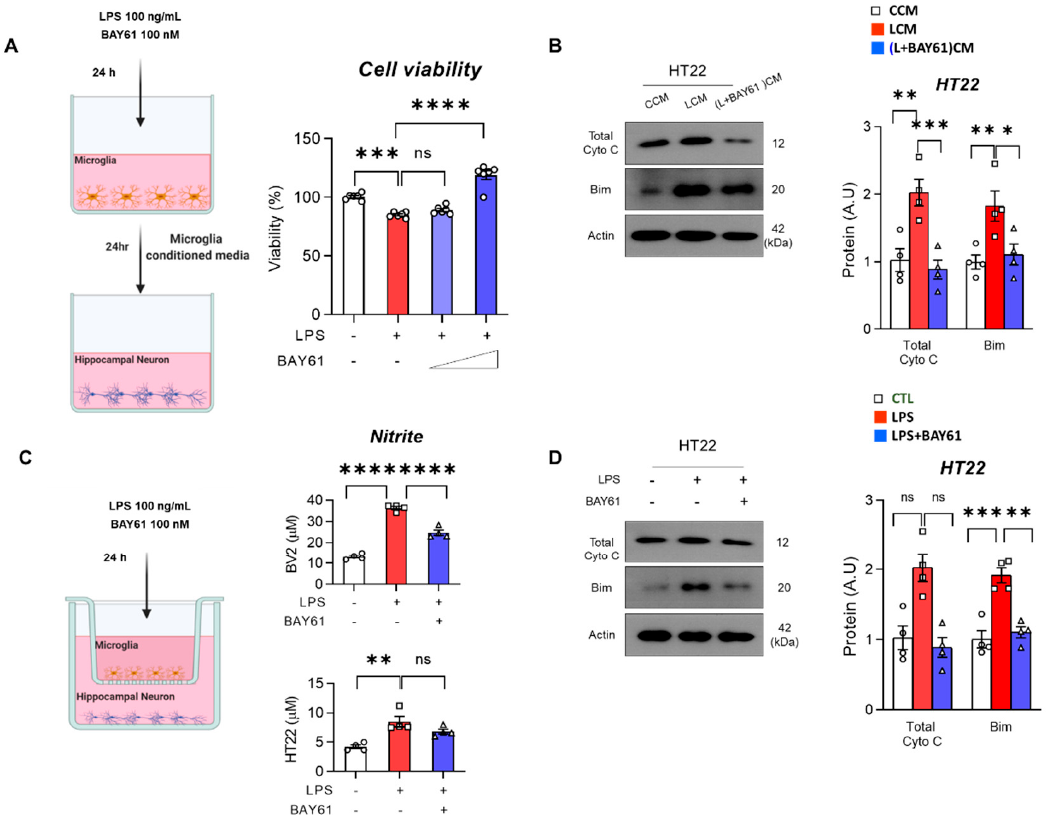
Figure 6. BAY61-3606 alleviates neurotoxin-mediated neurodegeneration in BV2. ( A ) Experimental scheme for microglia conditioned medium. Briefly, LPS (100 ng/mL) and BAY61-3606 (10 nM or 100 nM) were treated in BV2 for 24 h. After collecting microglia conditioned medium, it was treated by replacing original medium of hippocampal cell line HT22 for 24 h (left), and cell viability (%) was measured using MTT assay (right). ( B ) Immunoblot of Total Cyto C and Bim to investigate neuronal cell death in HT22 cells exposed to LPS-treated microglia conditioned medium (LCM) ( n = 4). ( C ) Experimental schemes of transwell-based co-culture system of BV2 and HT22 (left). Nitrite was measured at transwell permeable supports containing BV2 and plate containing HT22 (right). ( D ) Immunoblot of Total Cyto C and Bim to detect neuronal cell death by paracrine manner of LPS-induced microglia activation. Bar graph color, white: control, red: LPS, blue: LPS with BAY61-3606. Values indicate the mean ± SEM. The significant differences have been given in the graphs as follows: ns: not significant, ns, non-significant, * p < 0.05, ** p < 0.005, *** p < 0.0001, **** p < 0.00001 compared with a group of interests and determined by one-way ANOVA followed by Tukey’s multiple comparison test. Abbreviations: Syk, tyrosine-protein kinase; LPS, lipopolysaccharide; Bim, BCL-2-like protein 11.